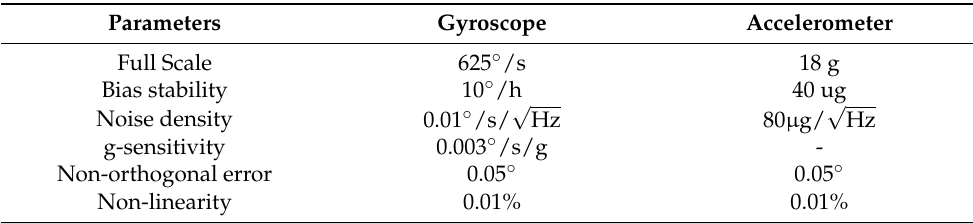
Table 1. Specifications of inertial sensors.